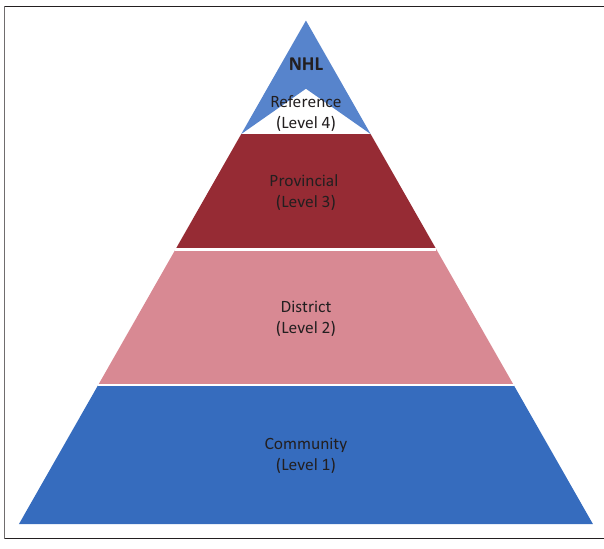
FIGURE 1: The integrated Tiered Laboratory Network (Level 4 in some countries includes the reference laboratories and the National Public Health Laboratory is on top of the TABLE 1: Example of laboratory tests and services needed at each level of a tiered national laboratory network. Laboratory Tier